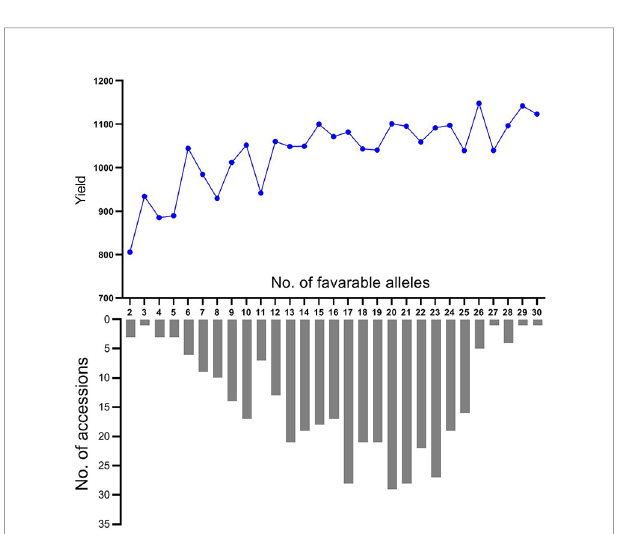
FIGURE 5 | Mean yield and the number of accessions with a varying number of favorable alleles at thirty-one